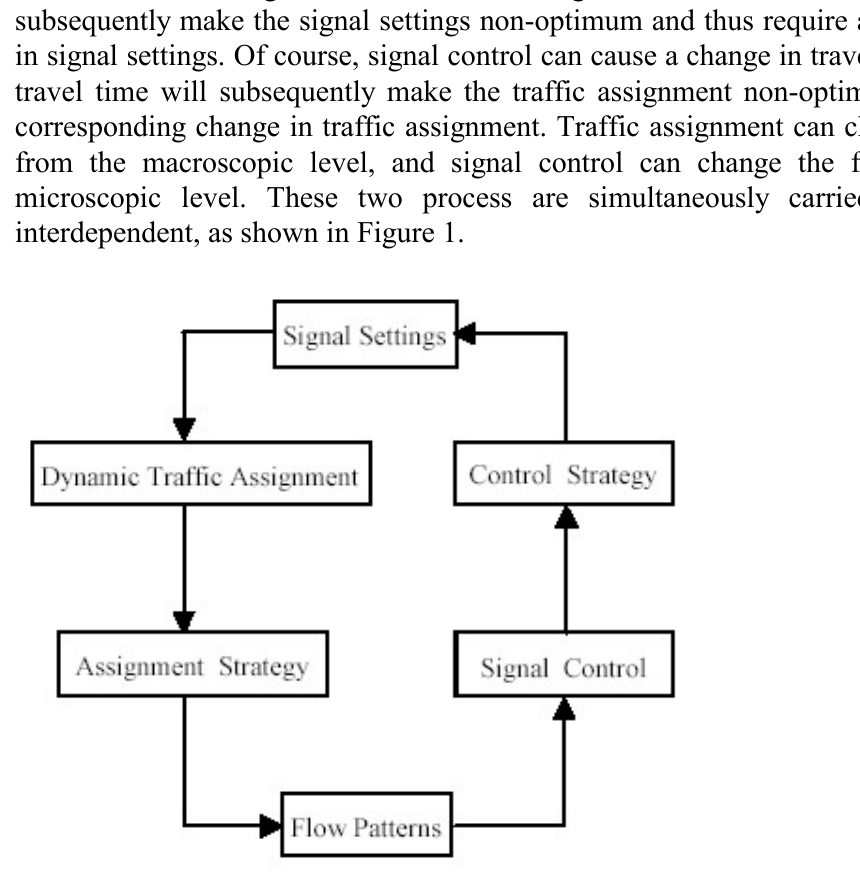
Figure 1. Interaction between traffic assignment and signal